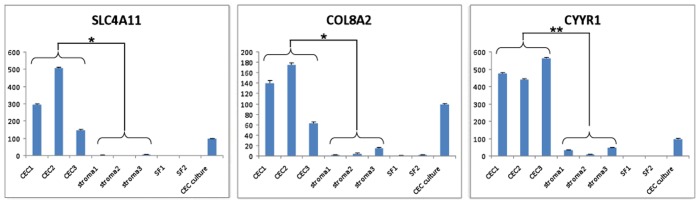
QPCR validation of gene expression in CEC-DM andcorneal stroma (keratocytes) from 3 individual donors, corneal stromal fibroblast cultures from 2 individual donors and CEC culture.CEC: CEC-DM; stroma: corneal stroma (keratocytes); SF: stromal fibroblast. Student’s t-tests (two-tailed assuming non-equal variance): One asterisk indicates p<0.05; two asterisks indicate p<0.01.